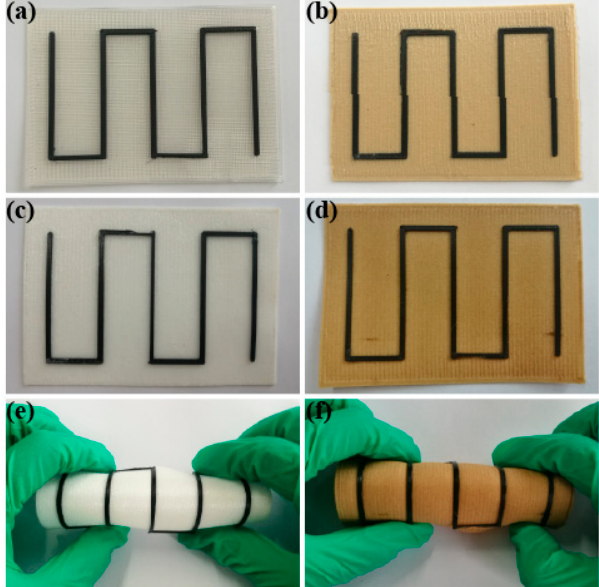
Figure 14. Patterns printed by FDM on different baseplates: patterns printed on PLA ( a ) and on PLA/wood flour composite ( b ); patterns printed on the flexible thermoplastic polyurethane (TPU) ( c ), on the TPU/wood flour composite ( d ), and their bent parts ( e , f ).